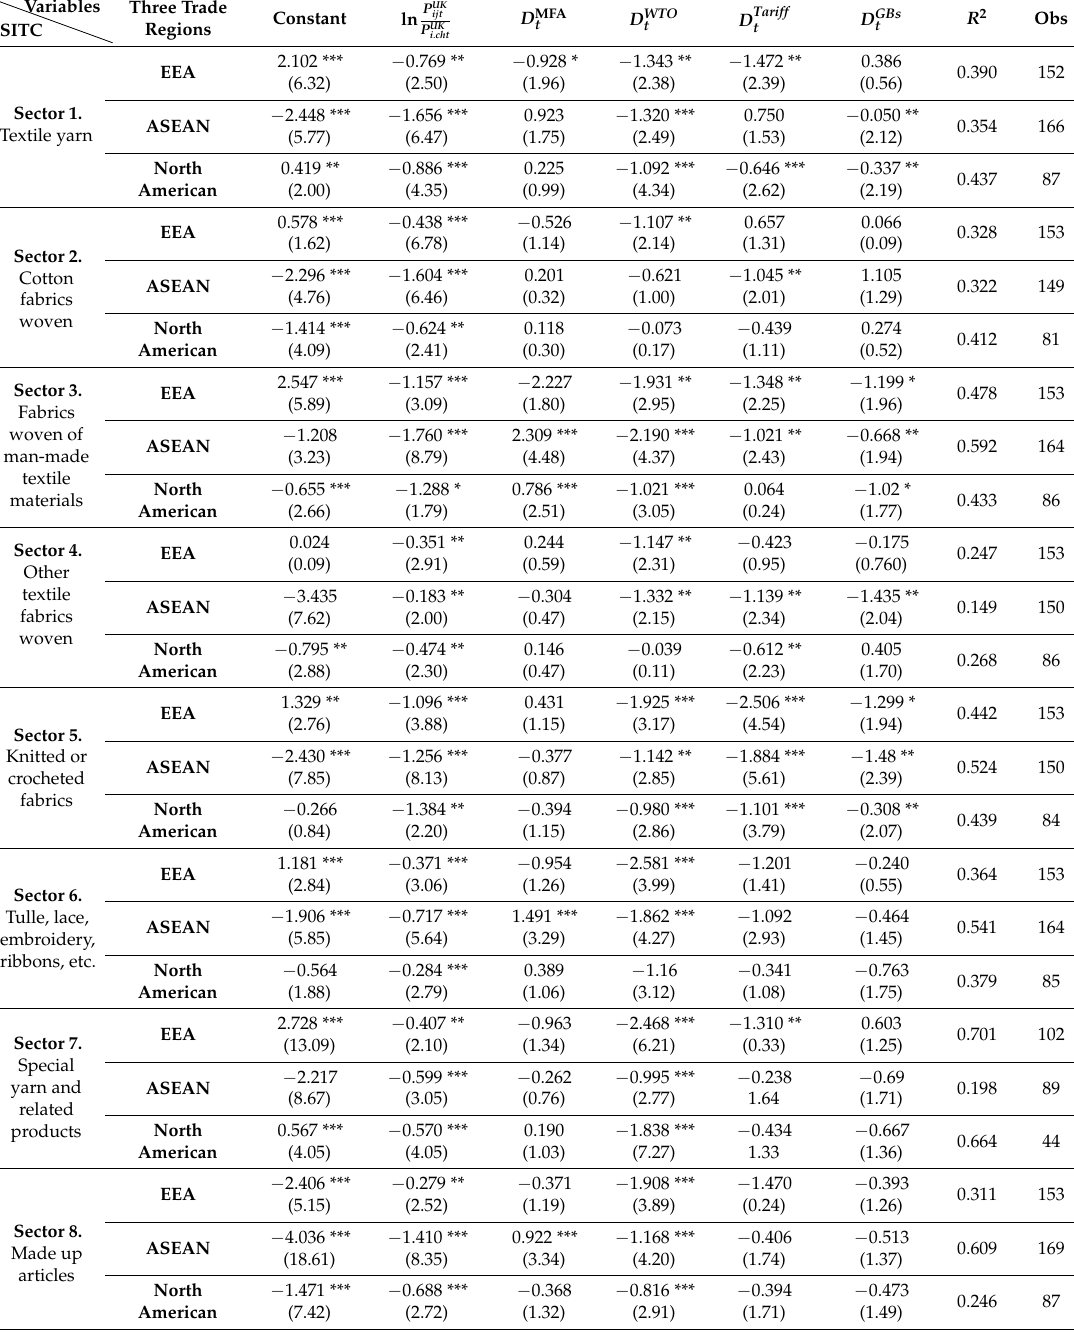
Table 10. Impact of Chinese textile raw materials on UK imports using the SUR